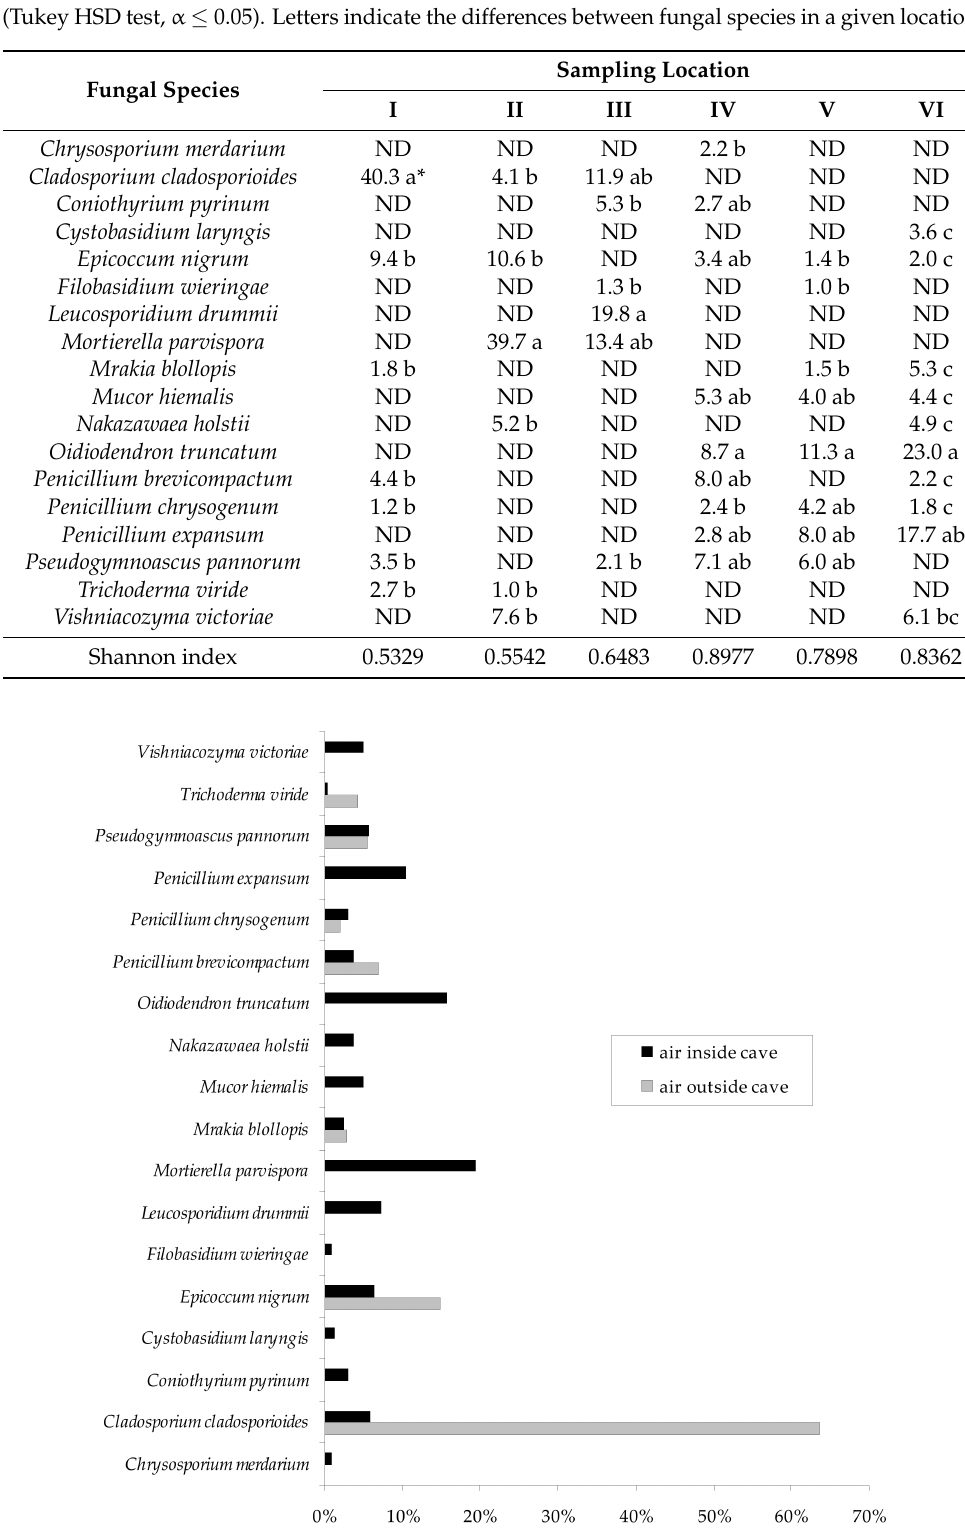
Figure 4. Percentage of each fungal species contributing to the totals from the internal and external air samples of the Brestovsk á